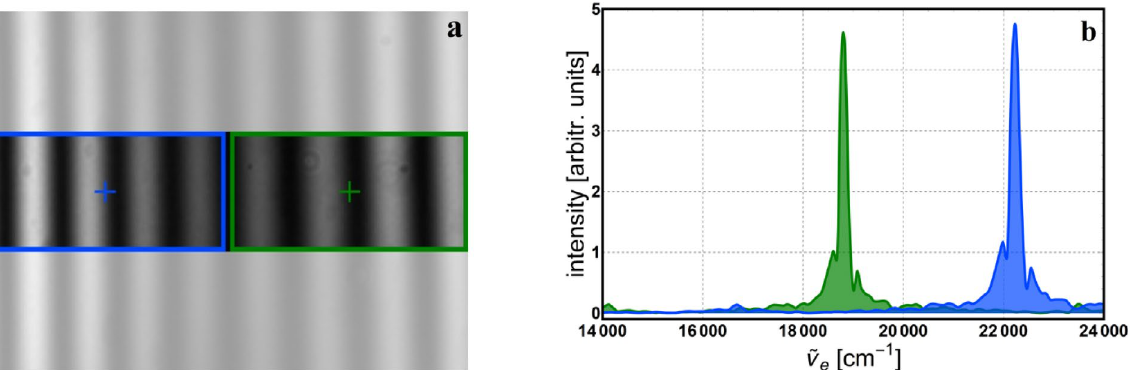
Figure 10. White LED light with left half passed through a blue filter (450 nm) and right half through a green filter (532 nm): ( a ) interferogram with selected areas and positions of the pixels used in the processing; ( b ) reconstructed monochromatic